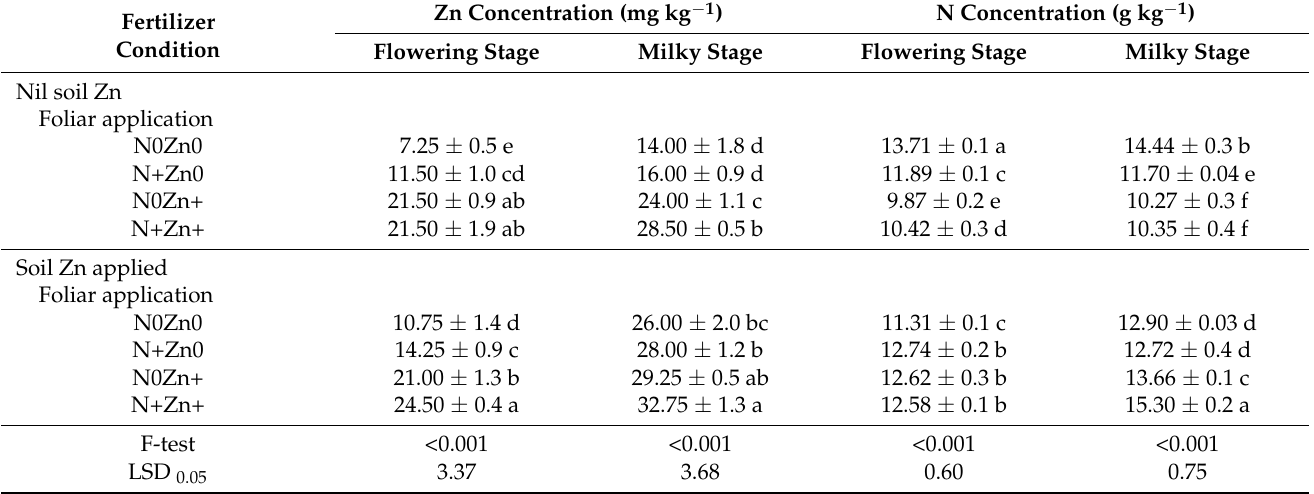
Table 1. Zn and N concentrations in brown rice SPT1 variety grown at different foliar N and Zn fertilizer rates under variation of soil Zn application at the flowering and milky stages. Each value is the mean of four independent replications ± standard deviation of the mean ( n =